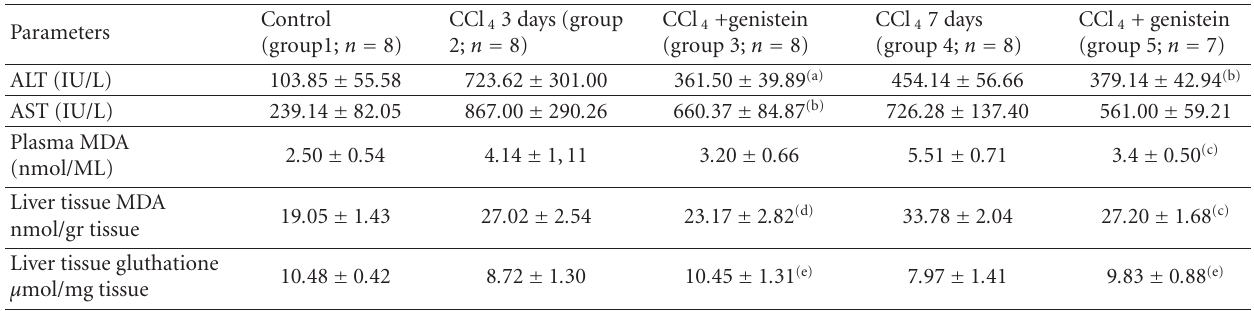
Table 1: Level of malondialdehyde (MDA) and gluathione, ALT, AST in groups.